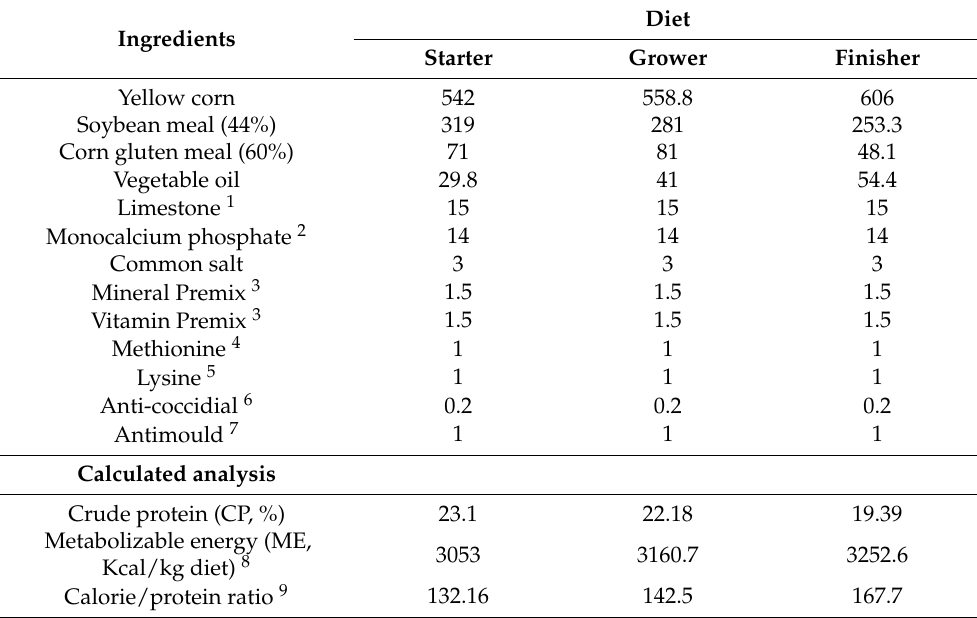
Table 1. Composition of experimental starter, grower, and finisher diets (g/kg diet) and the calculated chemical analysis of the basal diet. Ingredients